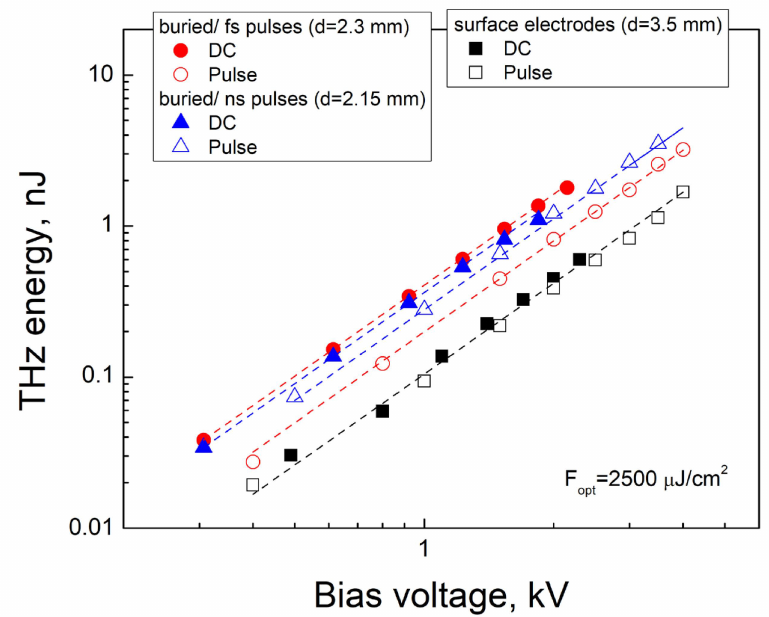
Figure 5. Experimental dependencies of THz pulse energy on bias voltage (DC and pulsed) for PCAs with surface electrodes and buried electrodes formed by fs and ns pulses. Square-law approximations are shown by dash